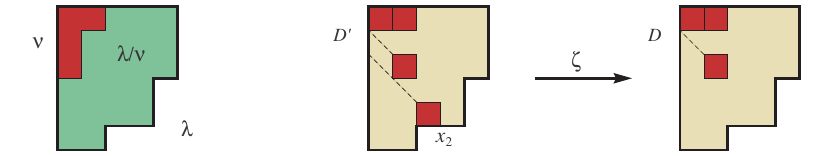
Figure 3.1: Skew Young diagram λ / ν , where λ = ( 5 , 5 , 5 , 4 , 4 , 2 ) and ν = ( 2 , 1 , 1 ) . Map ζ : D (cid:48) → D , where D (cid:48) ∈ ED ( λ / ν ) , D ∈ ED ( λ / µ ) , and D (cid:48) (cid:114) D = x 2 = ( 5 , 3 )